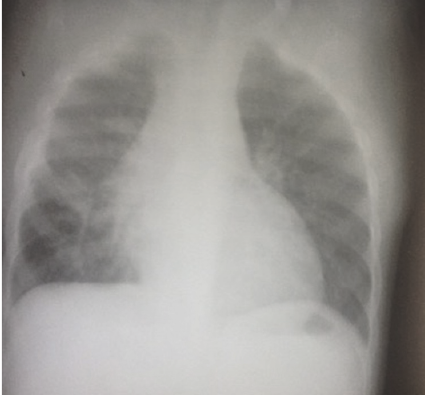
Figure 5: Chest X-ray, control one month after the surgery in the baby boy.